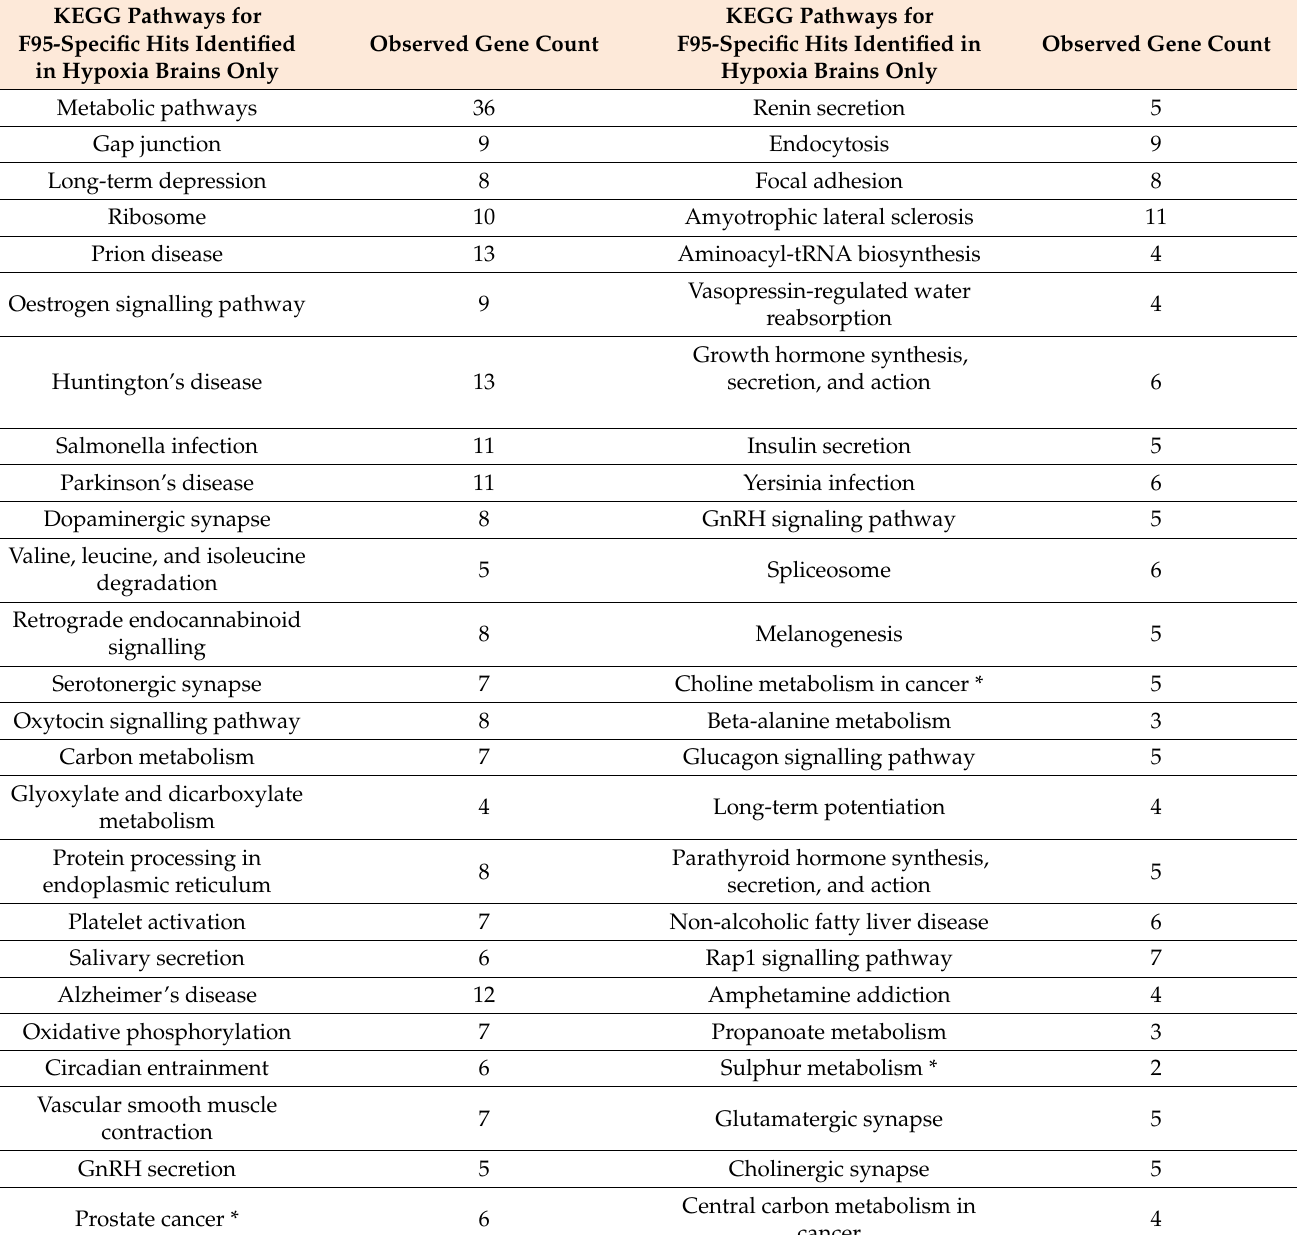
Table 7. KEGG pathways for F95 hits only identified in hypoxia brains (and not overlapping with the normoxia group). The 50 KEGG pathways are listed below that relate to the protein network built based on F95 hits in hypoxia brain only (shown in Figure 8B); the observed gene count for each pathway is listed; (*) are unique to this list